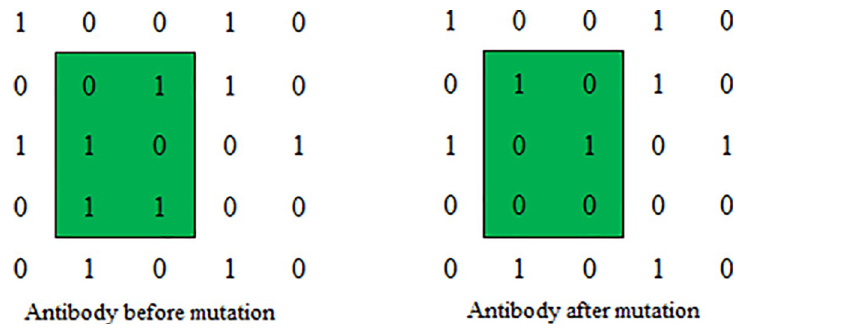
Fig 7. Random block mutation operation.